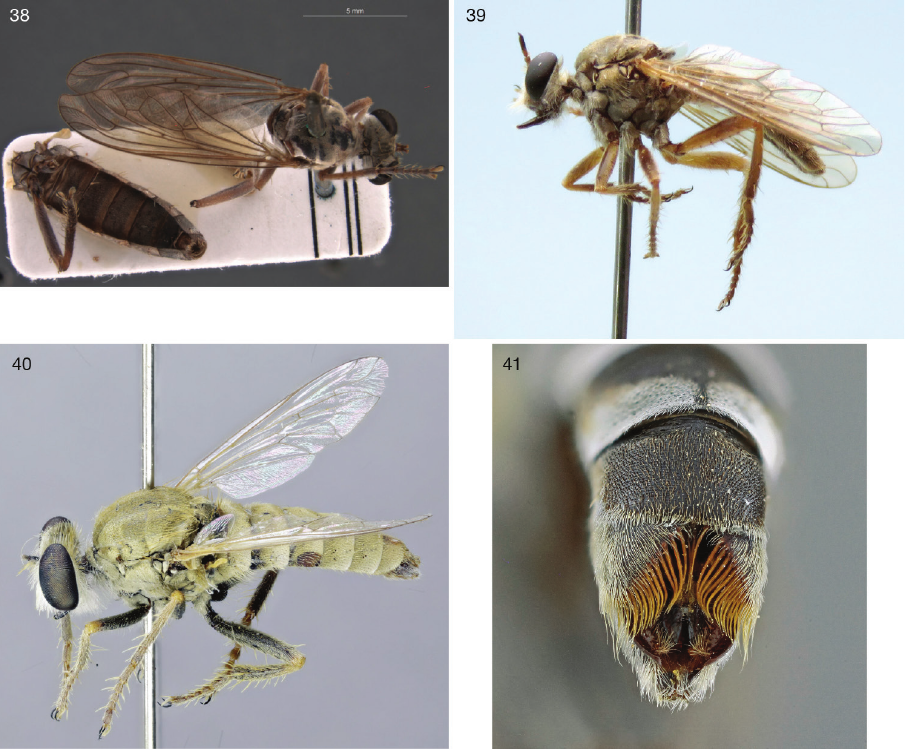
Figures 38–41. Photographs of Laphyctis species and detail of posterior gonocoxal setation: 38 L. gig- antella (holotype ♀ ) 39 L. iota sp. n. (Kruger Park ♂ ) 40 L. orichalcea (holotype ♂ ) 41 L. eremia sp. n. dorso-anterior view of hypopygium. Not to same